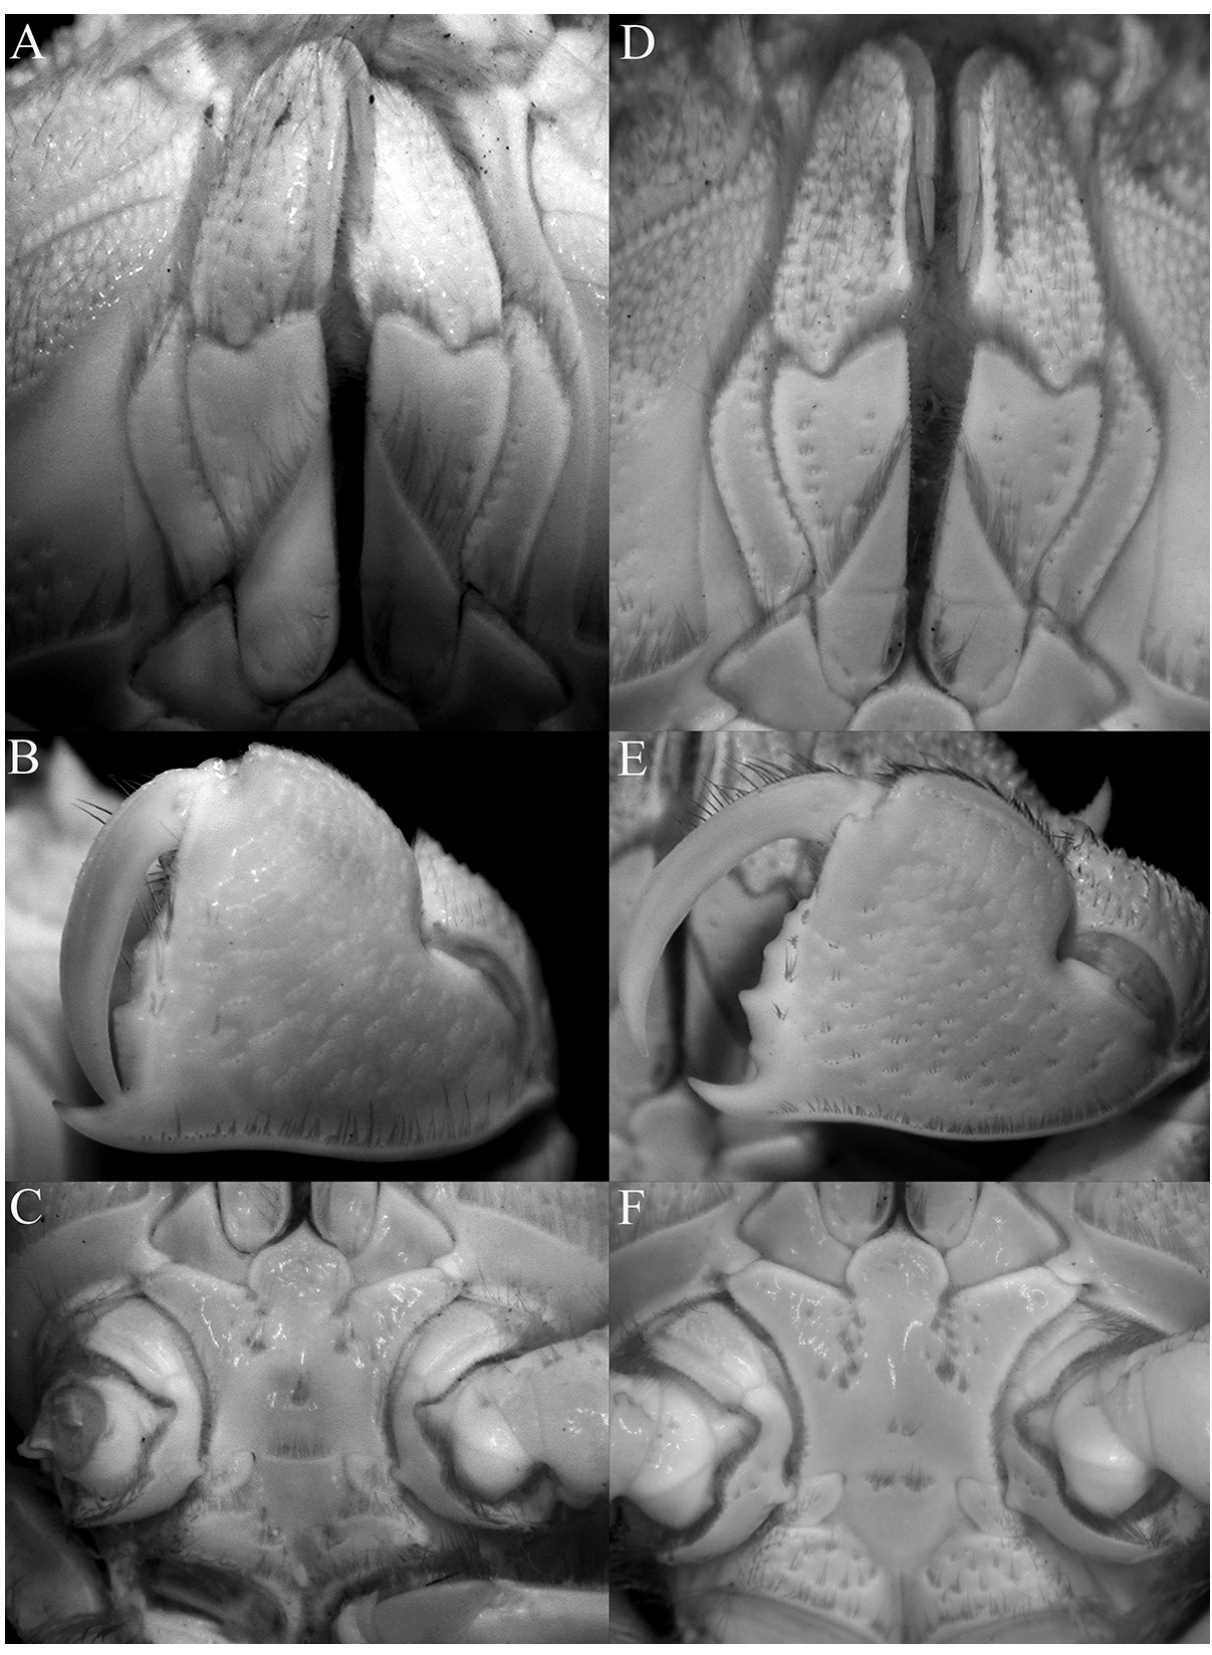
Figure 5. A–C, Umalia trirufomaculata , male (11.8 x 15.6 mm) (ZSI), Andamans; D–F, U. misakiensis , male (16.0 x 21.8 mm) (ZRC 2001.0637), Philippines. A, D, third maxillipeds; B, E, outer view of left chela; C, F, anterior thoracic